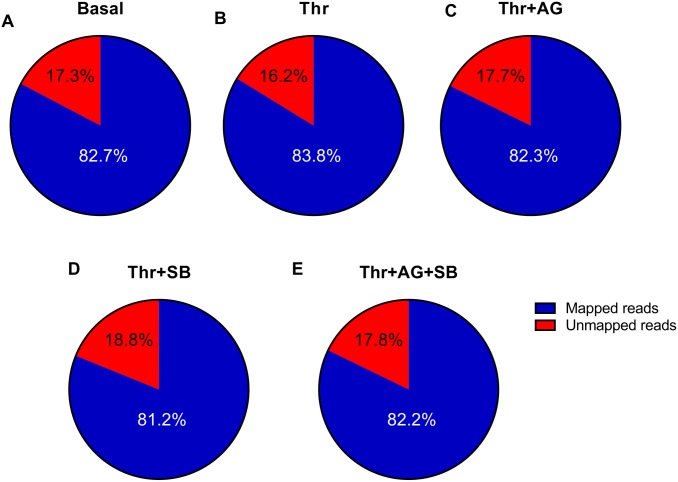
Summary of RNA-sequencing data.Average mapping statistics for each of individual treatments using TopHat. RNA extraction from human CASMCs A Untreated B treated with thrombin for 6 hours C treated with thrombin in the presence of AG1478 (5μM) D treated with thrombin in the presence of SB431542 (10μM) E treated with thrombin in the presence of both AG1478 and SB431542.